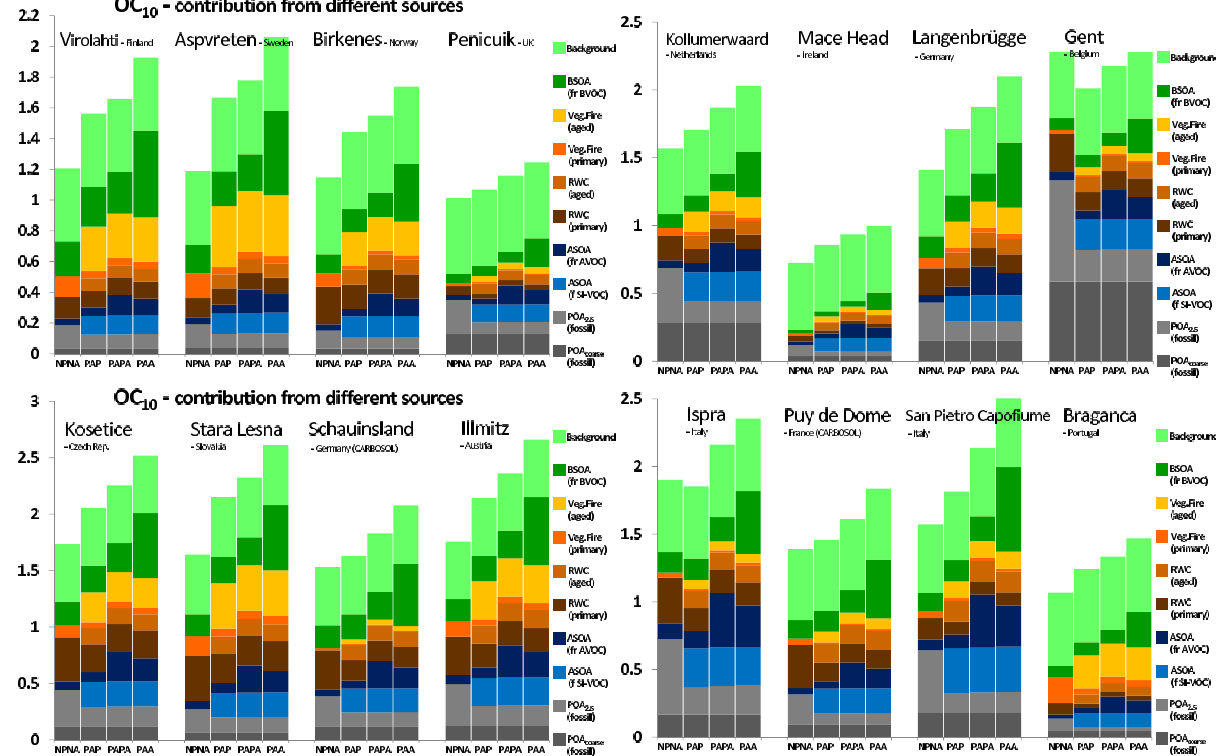
Fig. 5. Modelled contribution from different sources to OC PM , at sites from the EMEP EC/OC campaign 2002-2003 and the CARBOSOL 10 project, arranged from north to south. Long-term averages for the different model versions (NPNA, PAP, PAPA and PAA, see text). For most sites the data are averages for the period July 2002–June 2003 but for the two stations Schauinsland and Puy de Dome (from the CARBOSOL project), the averages are for October 2002–September 2004. Colours/Notation, Dark grey: primary OA in PM 2 . 5 − 10 (coarse mode); Light grey: primary OA in PM 2 . 5 ; medium blue: anthropogenic SOA from aged S/IVOC emissions; dark blue: anthropogenic SOA from VOC; dark brown: primary OA from Residential Wood Combustion (RWC); Light brown: aged OA from RWC S/IVOC emissions; orange: primary OA from vegetation fires (open-burning wildfires and agricultural fires); light orange: aged OA from vegetation fires; dark green: biogenic SOA from terpenes and isoprene; light green: background OA, from sources not included in the